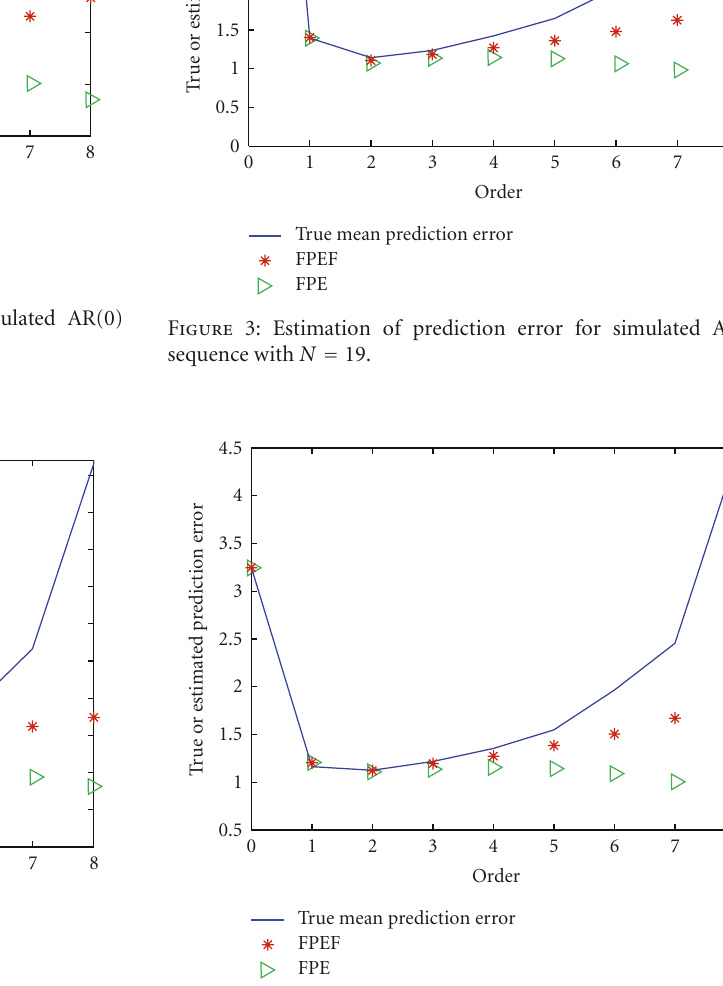
Figure 2: Estimation of prediction error for simulated AR(1) sequence with N = 19.